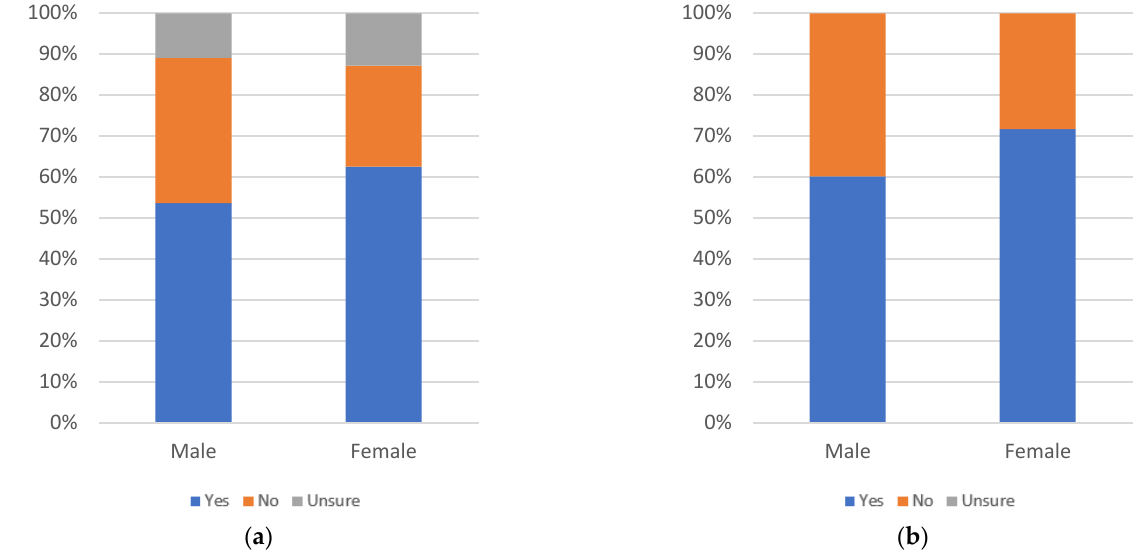
Figure 103. Label helpfulness, by gender: ( a ) with uncertain respondents (left) and ( b ) without uncertain respondents (right).